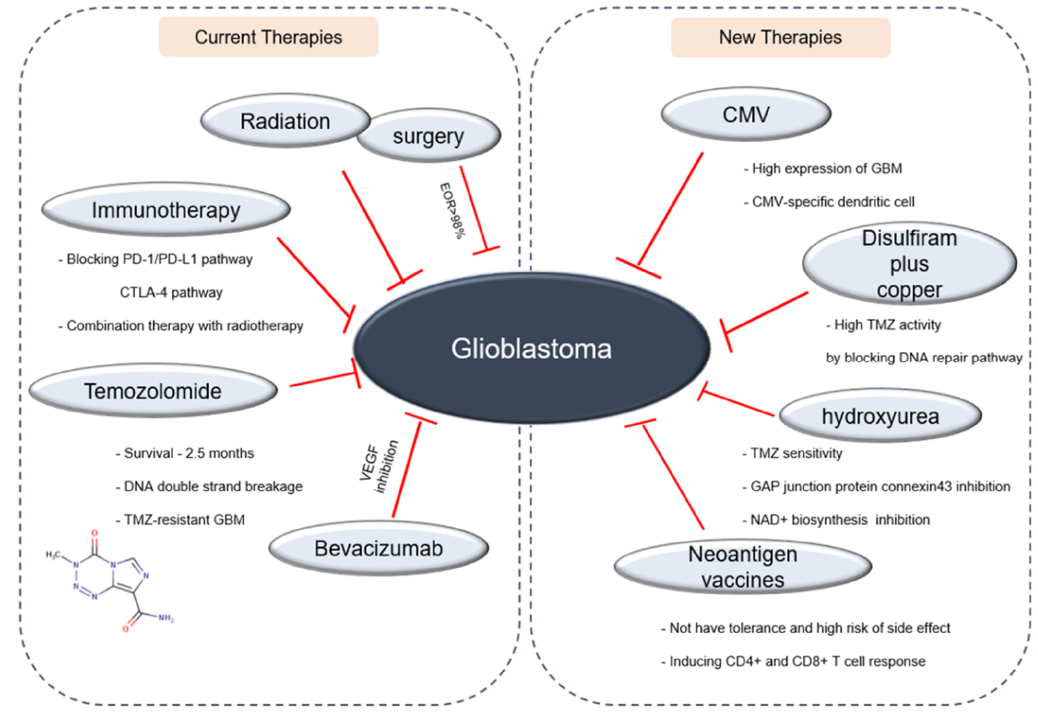
Figure 5. A schematic diagram showing the GBM therapies. A diagram demonstrates the current and new promising